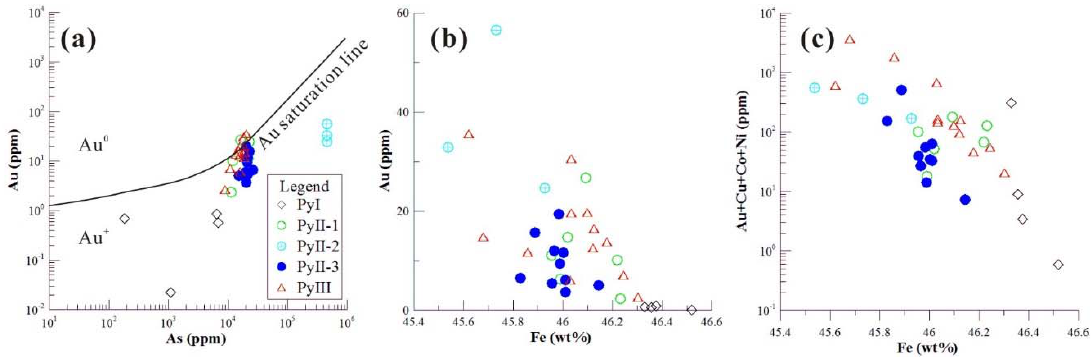
Figure 14. Plots of pyrite compositions (LA-ICP-MS data). ( a ) Au–As plot of pyrite is modified from Ref. [50,61]. ( b ) plot of Fe vs. Au; ( c ) plot of Fe vs. Au + Cu + Co + Ni.